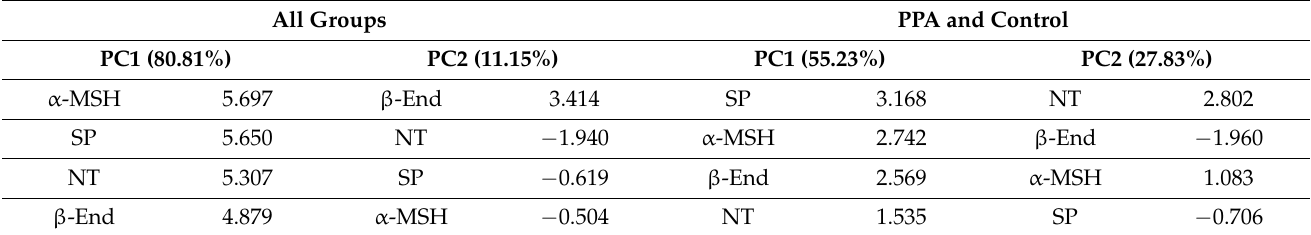
Table 1. Contribution of variables to PC1 and PC2 in principal component analysis. Note: while determining variable contributions to principal components, only the magnitude of the contribution is considered, with no regard for directionality (i.e., plus or minus sign) because contributions in either the positive or negative direction equally explain the variance.